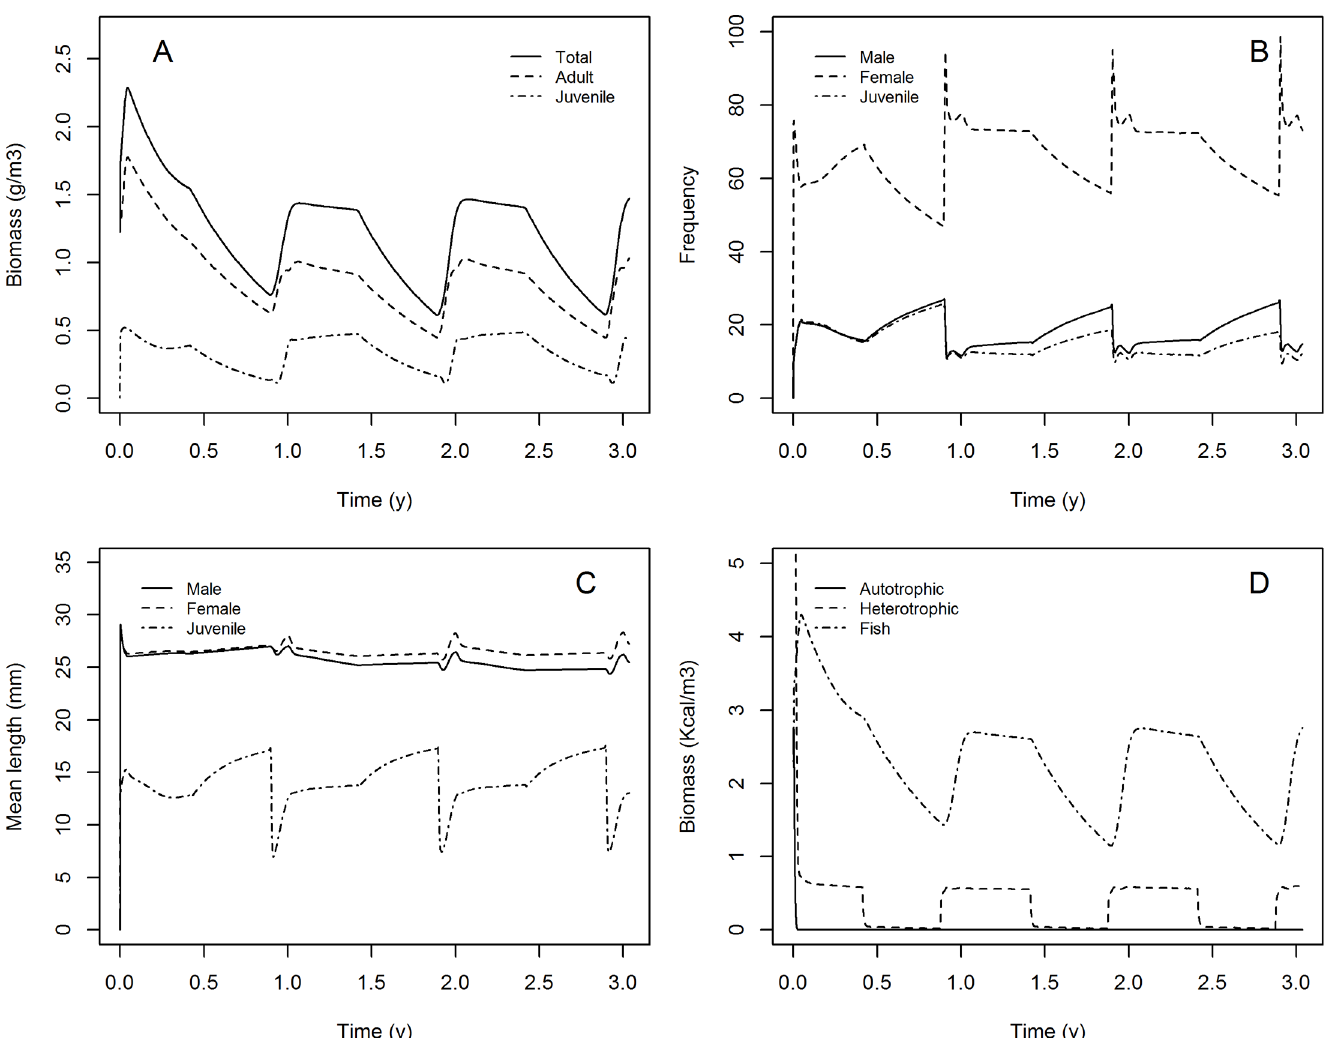
Fig 8. Zebrafish population dynamics predicted through three years. (A) zebrafish biomass, (B) frequencies of the different fish stages (excluding eggs- larvae), (C) mean length of the different zebrafish stages, and (D) food dynamic state